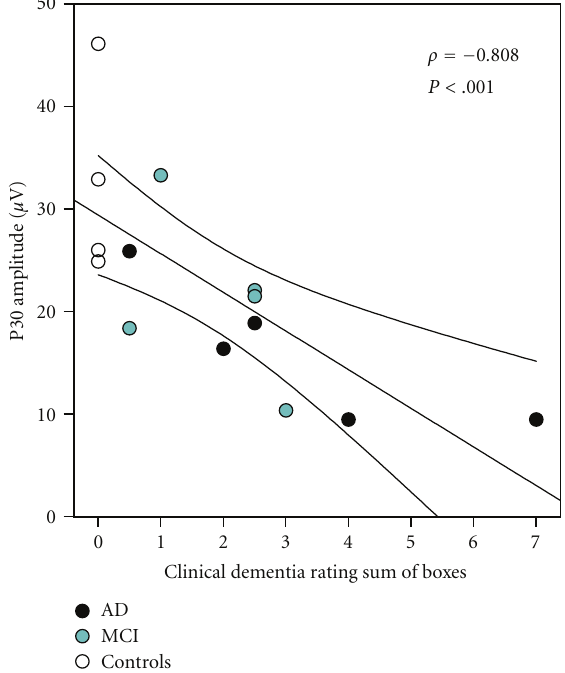
Figure 5: Scatter plot indicating the relation between the clinical dementia rating sum of boxes and P30 amplitude (average of each subject’s left and right hemisphere measurement, P30 mean ). The thin curved lines represent the 95% confidence intervals for the curve